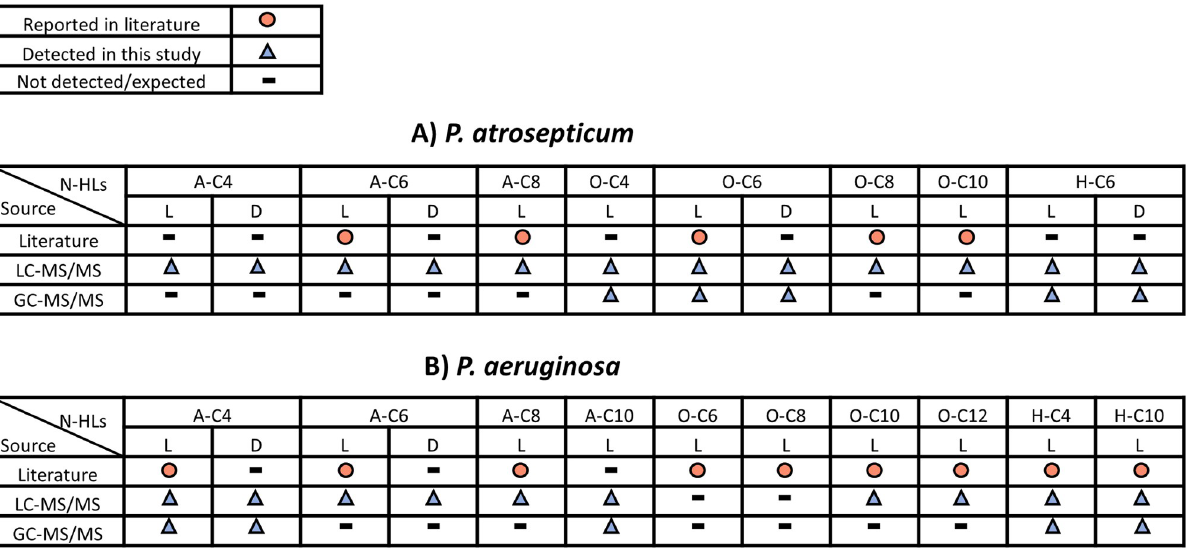
Fig 2. N-HLs detected in by LC-MS/MS and GC-MS/MS compared to N-HLs reported previously in the literature. (A) P . atrosepticum and (B) P . aeruginosa . Sources of previously reported N-HLs referenced in Results and Discussions.